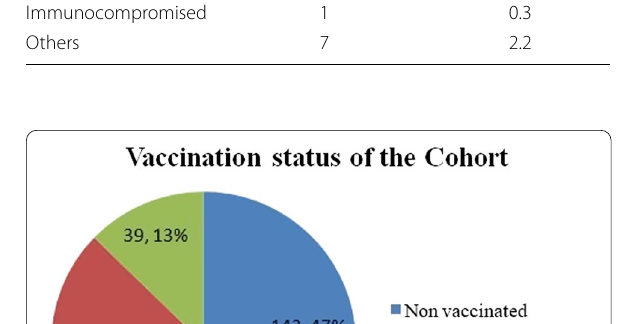
Table 2 Presenting symptoms of the cohort